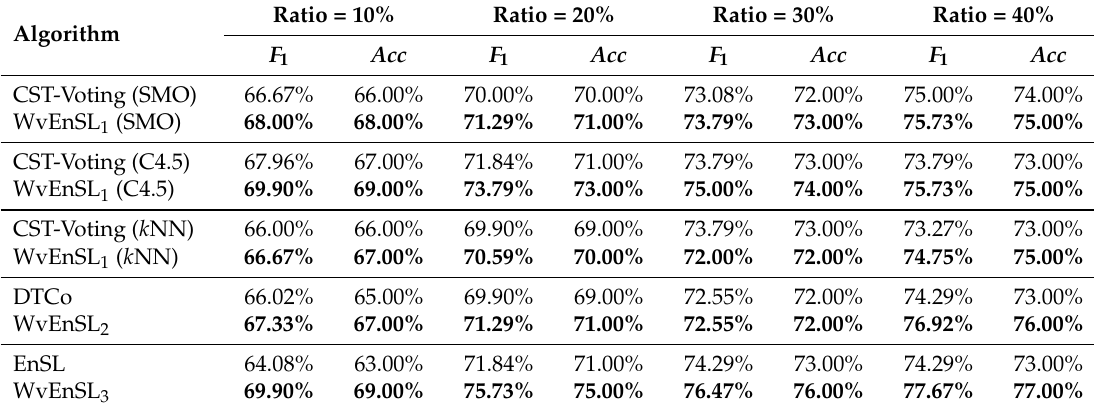
Table 4. Performance evaluation of WvEnSL against ensemble self-labeled algorithms for CT Medical